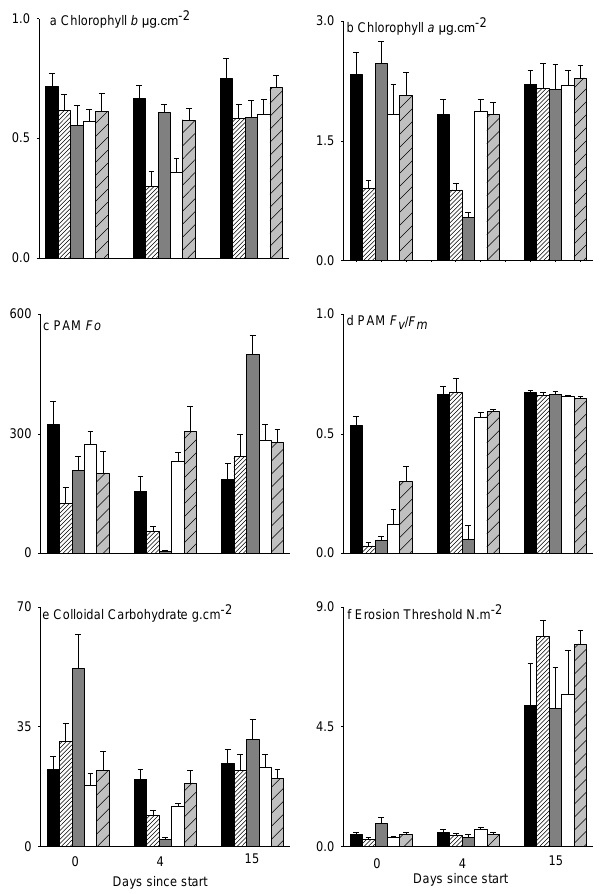
Fig. 2. Means (+ S.E., n = 3 plots) of variables in sediments treated in situ: black, undisturbed; fine stripe, H 2 O 2 ; grey, formalin; white, liquid N 2 ; coarse stripe, PC3 (details in